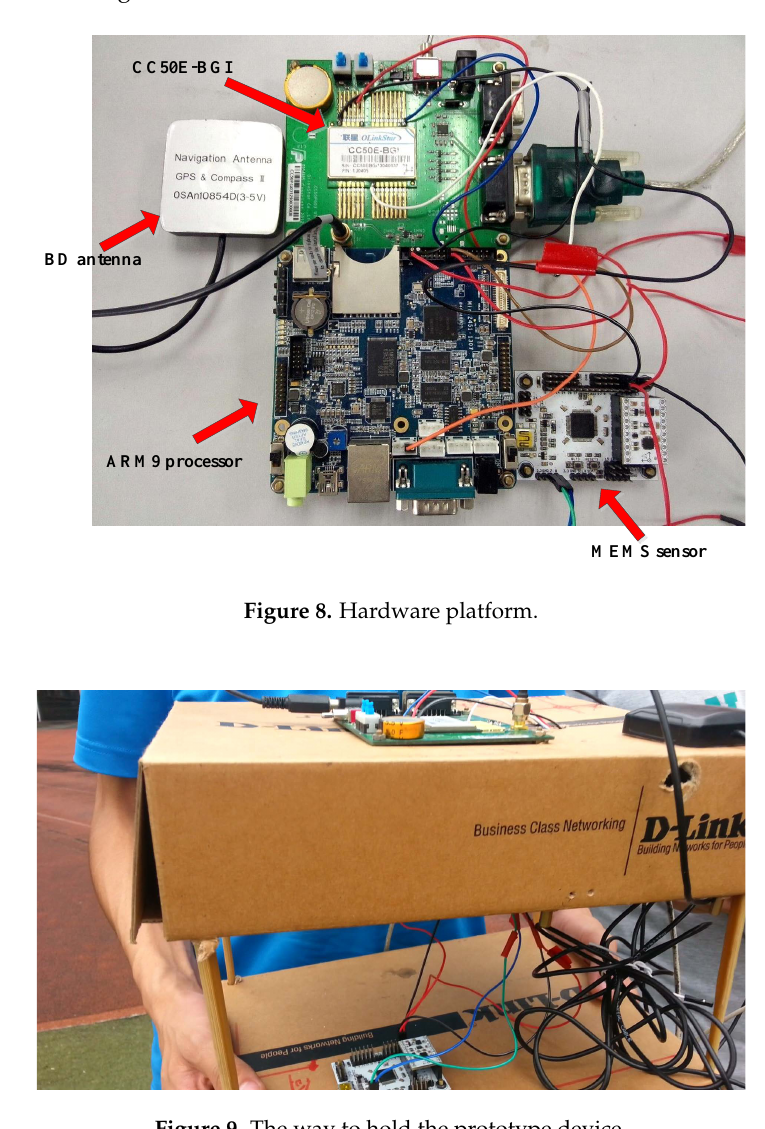
Figure 9. The way to hold the prototype